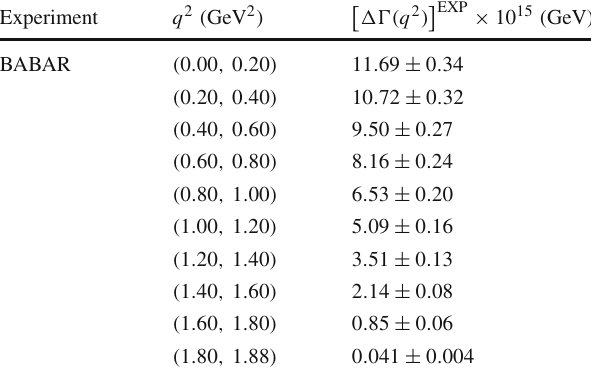
(cid:10) (cid:11) EXP for the D → K (cid:6)(cid:5)( q 2 )